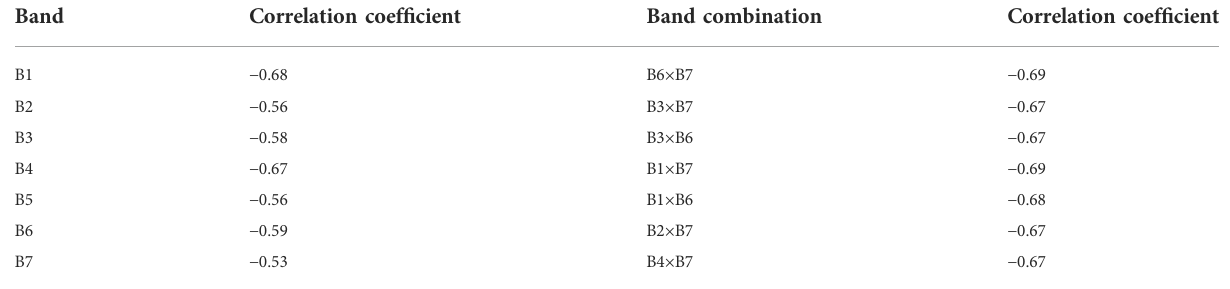
TABLE 1 Sensitive spectral bands of PC concentration for MODIS sensor.